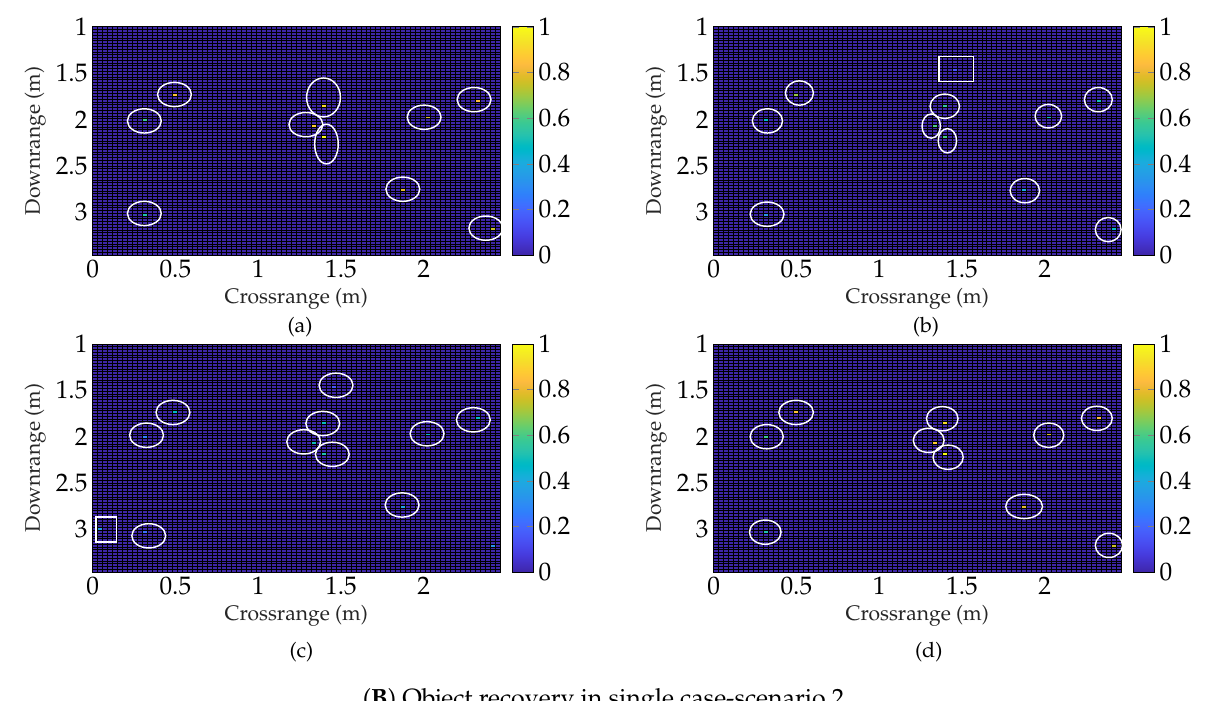
( B ) Object recovery in single case-scenario 2. Figure 16. Object recovery for a single case with compression ratio K / MN = 20% with M = N = 100. ( a ) Ground-truth, ( b ) TRPCA-AT(log) (proposed), ( c ) URPCA-T and ( d ) SP with 100% of data. The proposed TRPCA-AT(log) approach is able to identify all nine objects success- fully by only utilizing 20% of data. True locations of the objects are shown inside ellipses and false detections are shown in